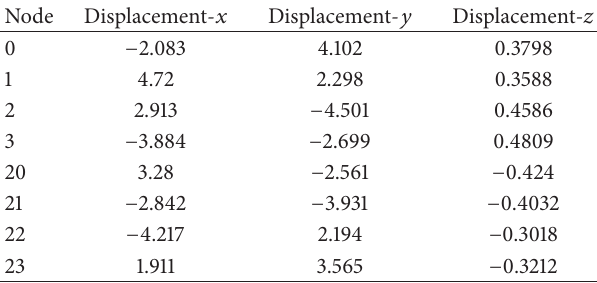
Table 4: The displacements (in m) at green nodes using the nonlinear FEM for the second experiment. The displacements at blue nodes are